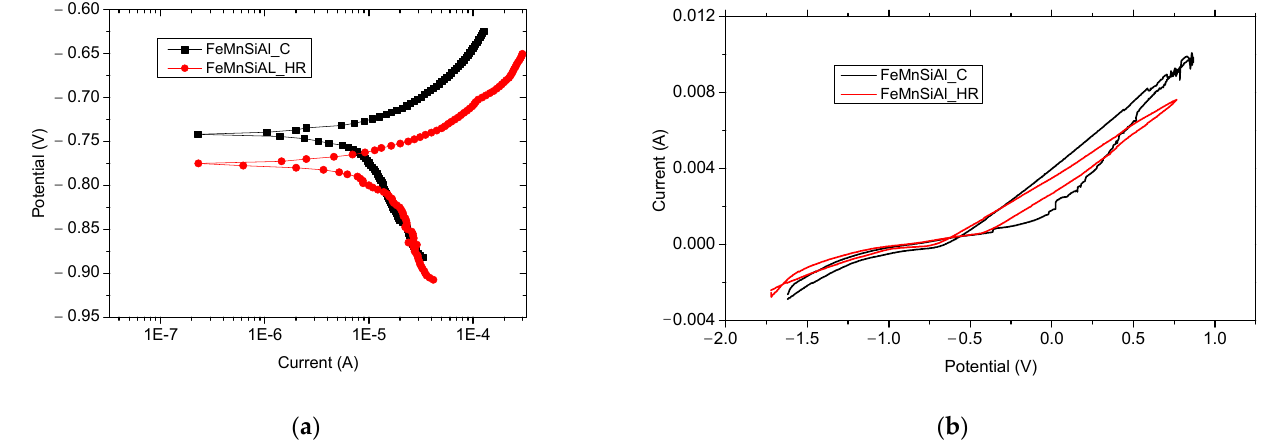
Figure 8. The electro-corrosion results: ( a ) the Tafel plots of C and HR FeMnSiAl alloy; ( b ) the cyclic curves voltammograms.